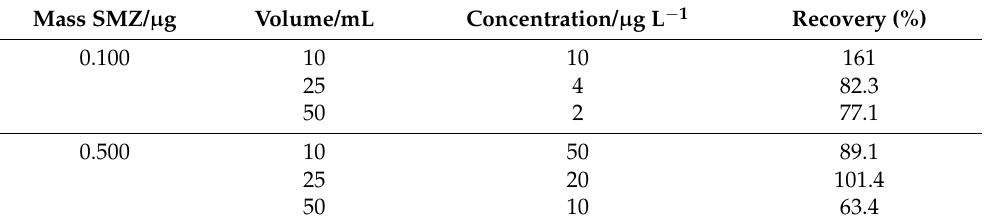
Table 2. Recovery results for loading SMZ using different concentrations and